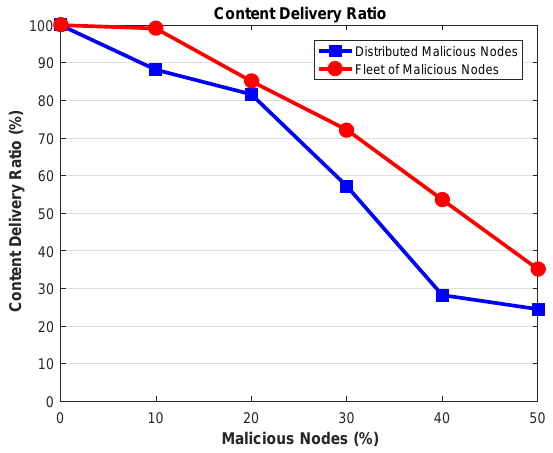
Figure 9. Content Delivery